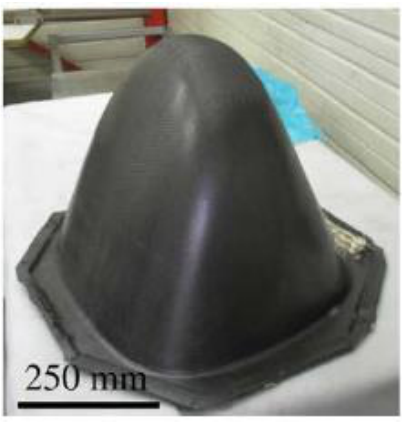
Figure 1. The canopy described in Refference [4] (1:3 scale prototype of the real